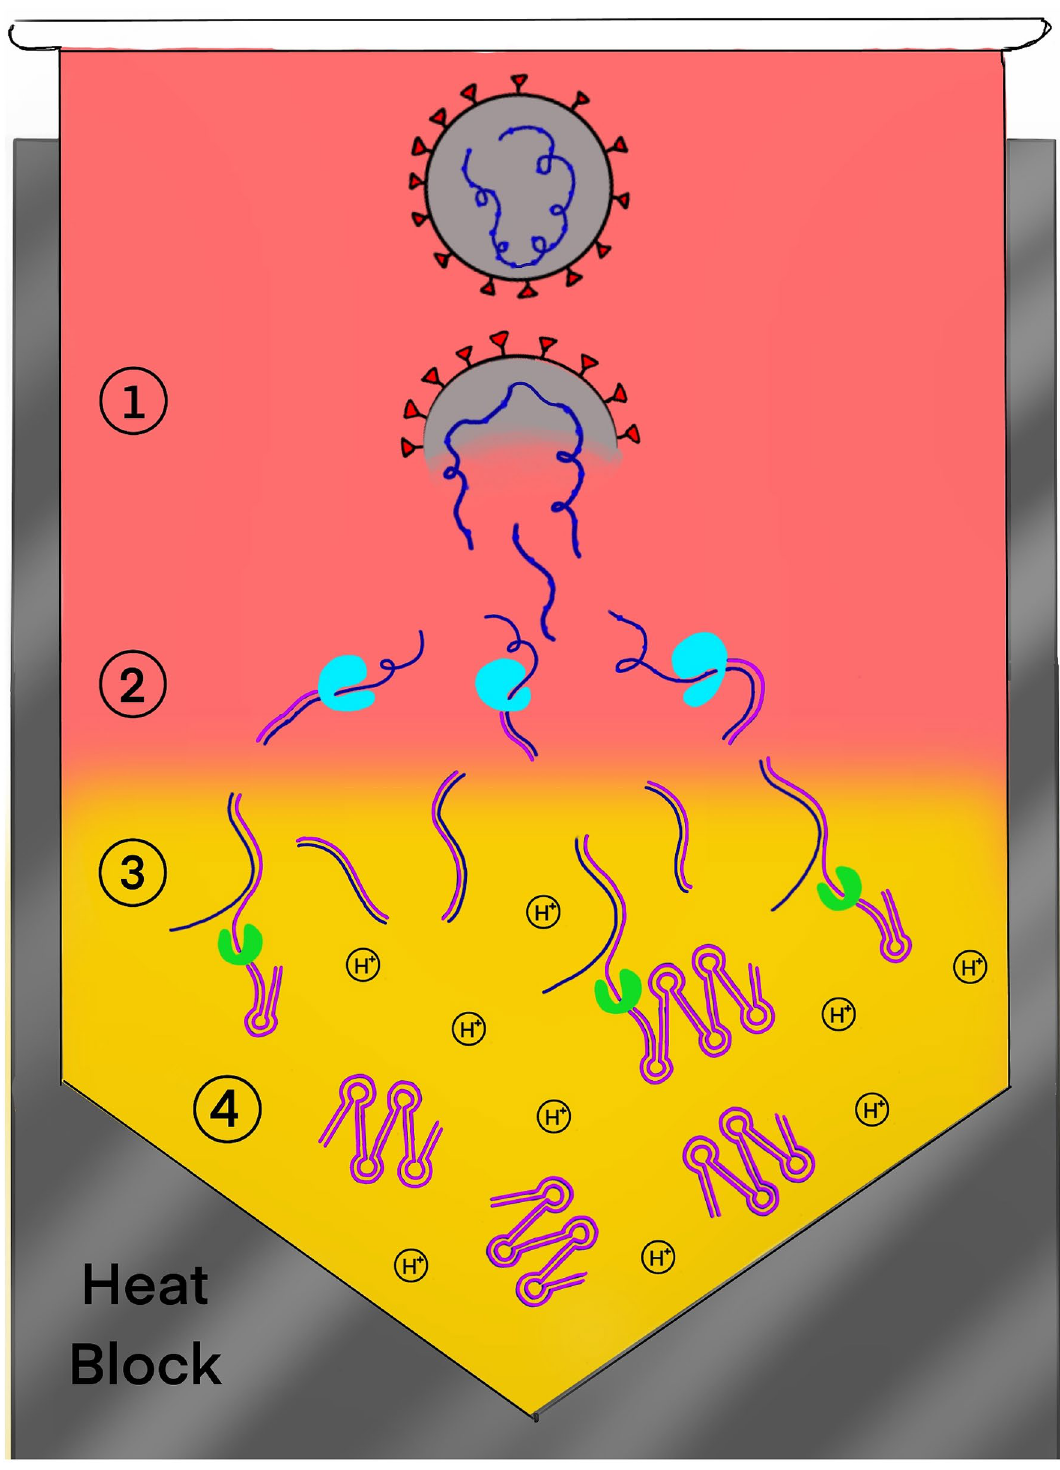
Figure 1. Diagram illustrating the principle of the HP-LAMP assay. Four steps occur within a single microcentrifuge tube containing the HP-LAMP cocktail. These steps consist of (1) Heat-mediated release of the single-stranded RNA virus (blue) from the virion, (2) Reverse transcription of the single-stranded viral RNA to generate cDNA (purple), (3) Loop-mediated amplification (LAMP) resulting in a decrease in pH, (4) Color change caused by decreased pH. The addition of RNA, DNA and RNAse inhibitors to the HP-LAMP cocktail inhibits degradation of the viral RNA by RNAses naturally found in